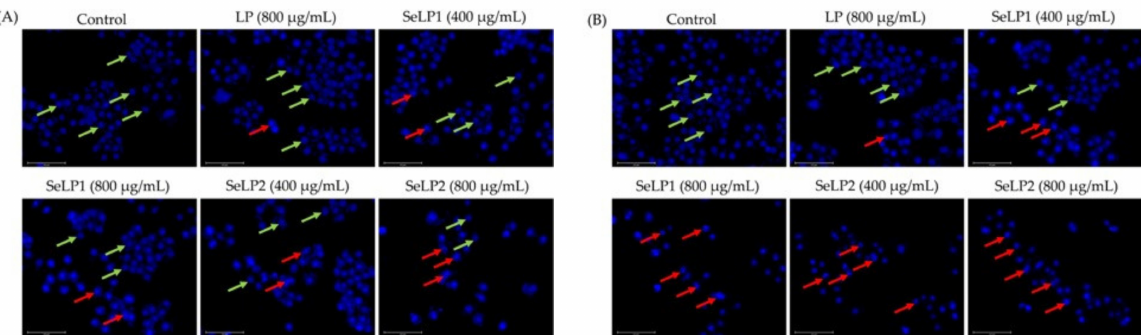
Figure 2. Morphological features of HT-29 cells treated with cell medium (control), longan polysac- charides (LP), and selenylated polysaccharides (SeLP1 and SeLP2) for 24 h ( A ) and 48 h ( B ). The green arrows indicate normal cells, while the red ones indicate the cells with morphological alteration.